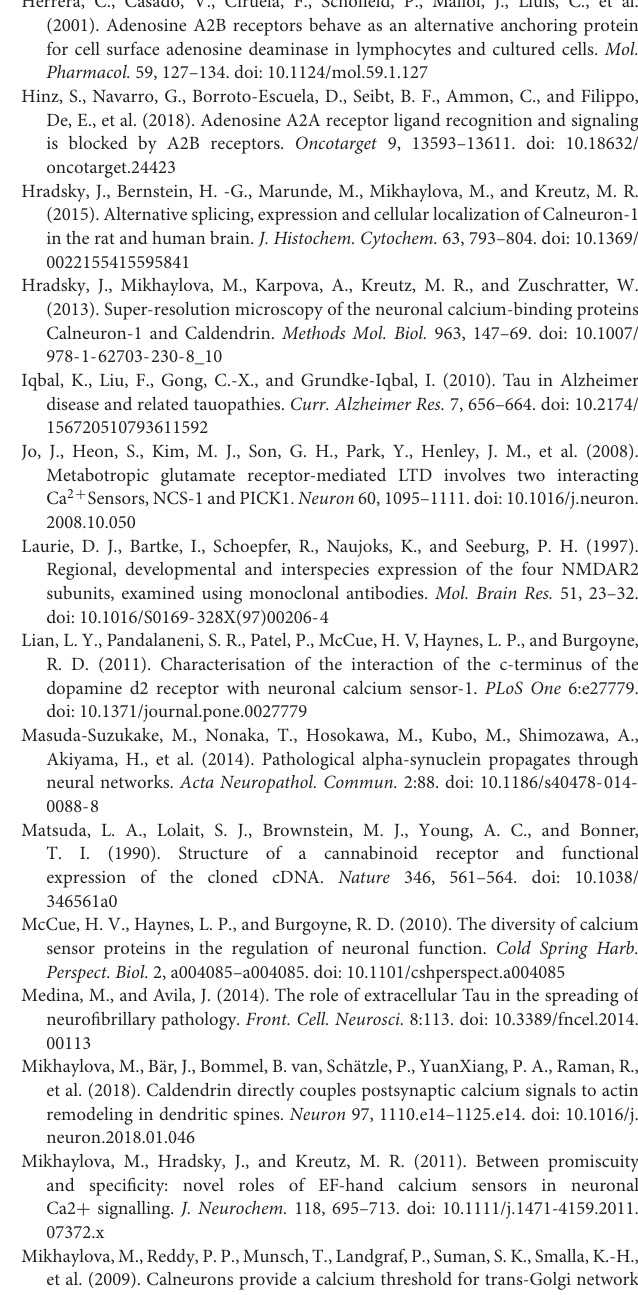
FIGURE S5 | Rescue of (endogenous) CaM silencing upon transfection with the cDNA for CaM. (A,B) MAPK phosphorylation levels were analyzed after stimulating primary cultures of cortical neurons (A) or cortical microglia (B) with 15 µ M NMDA. Experiments were performed in cells transfected or not with siRNA to silence CaM; 24 h later, cells were transfected with cDNA for CaM or with the (empty) pcDNA3.1 vector. Experiments in untransfected (left), in siRNA (center), and in siRNA plus CaM (right) cells were preformed simultaneously. Data are the mean ± SEM ( n = 5). One-way ANOVA followed by Bonferroni’s multiple comparison post hoc test were used for statistics analysis ( ∗ p < 0.05, ∗∗ p < 0.01 versus NMDA